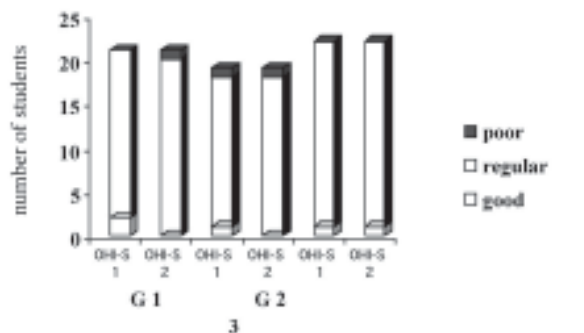
FIGURE 2 - OHI-S in the initial and final stages in Groups 1, 2 and 3 (G1, G2 and G3) in students aged 12 to 14